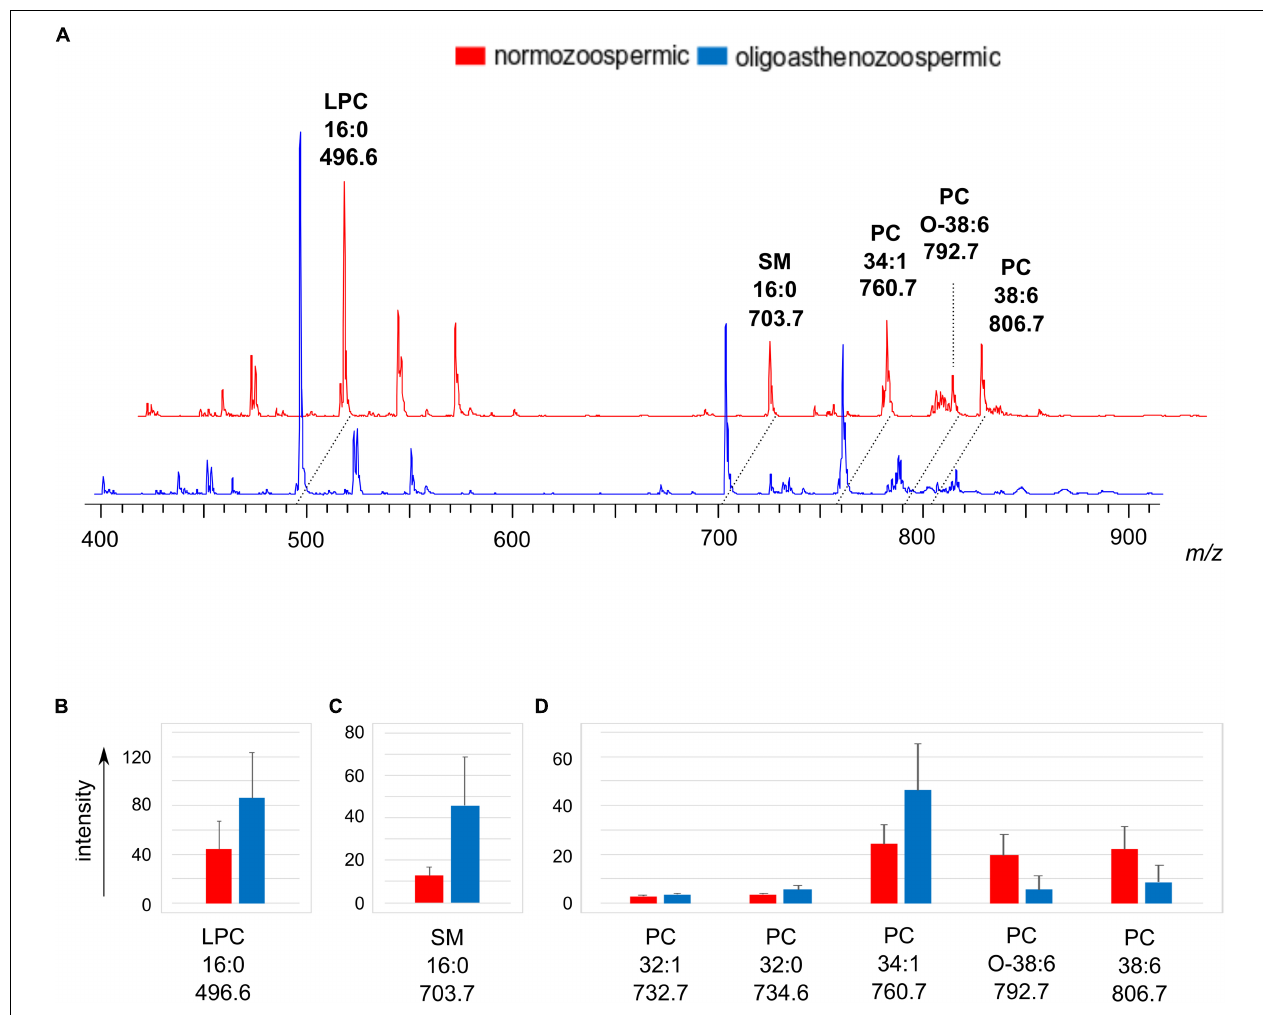
FIGURE 4 | Positive ion mode MALDI-TOF/MS analyses of the lipid extracts of semen of normozoospermic subjects and oligoasthenozoospermic patients. In panel (A) , two typical lipid profiles are shown. Main species of lipid classes are reported: LPC 16:0 [M+H] + at m/z 496.6; SM 16:0 [M+H] + at m/z 703.7; PC 34:1 [M+H] + at m/z 760.7; PC O-38:6 [M+H] + at m/z 792.7 and PC 38:6 [M+H] + at m/z 806.7. The histograms show the significant differences in intensity of lipid peaks at m/z 496.6 corresponding to LPC (B) , at m/z 703.7 corresponding to SM (C) , at m/z 732.7, 734.6, 760.7, 792.7, 806.7 corresponding to PC species (D) . A p -value from Student’s t -test < 0.05 was set as the threshold to define significant differences between the peaks present in the two series of spectra. Data are reported as the average value ±